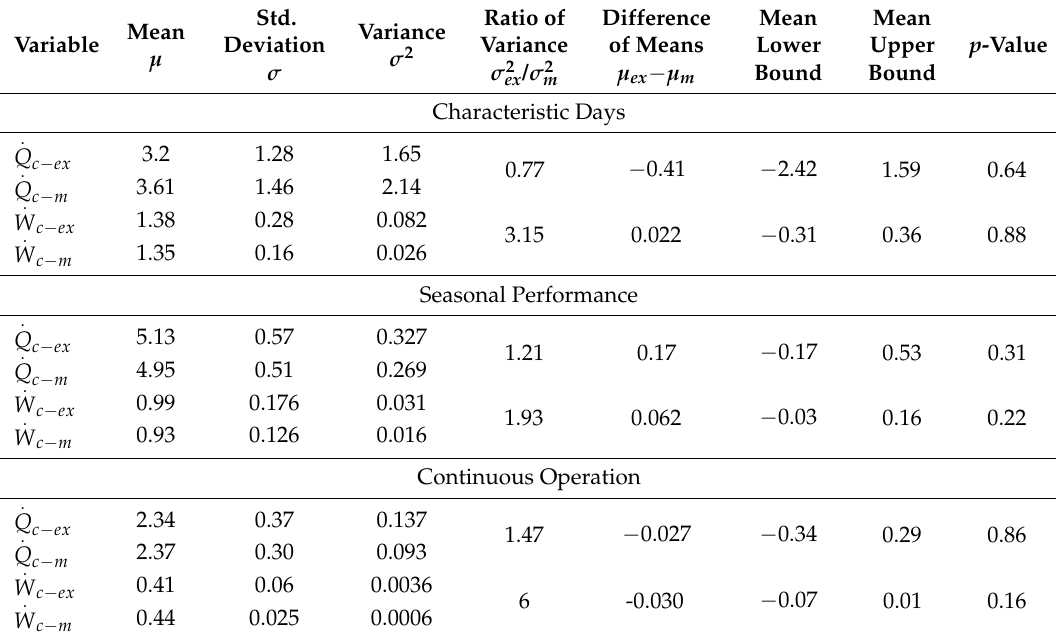
Table 1. Summary of the two independent sample